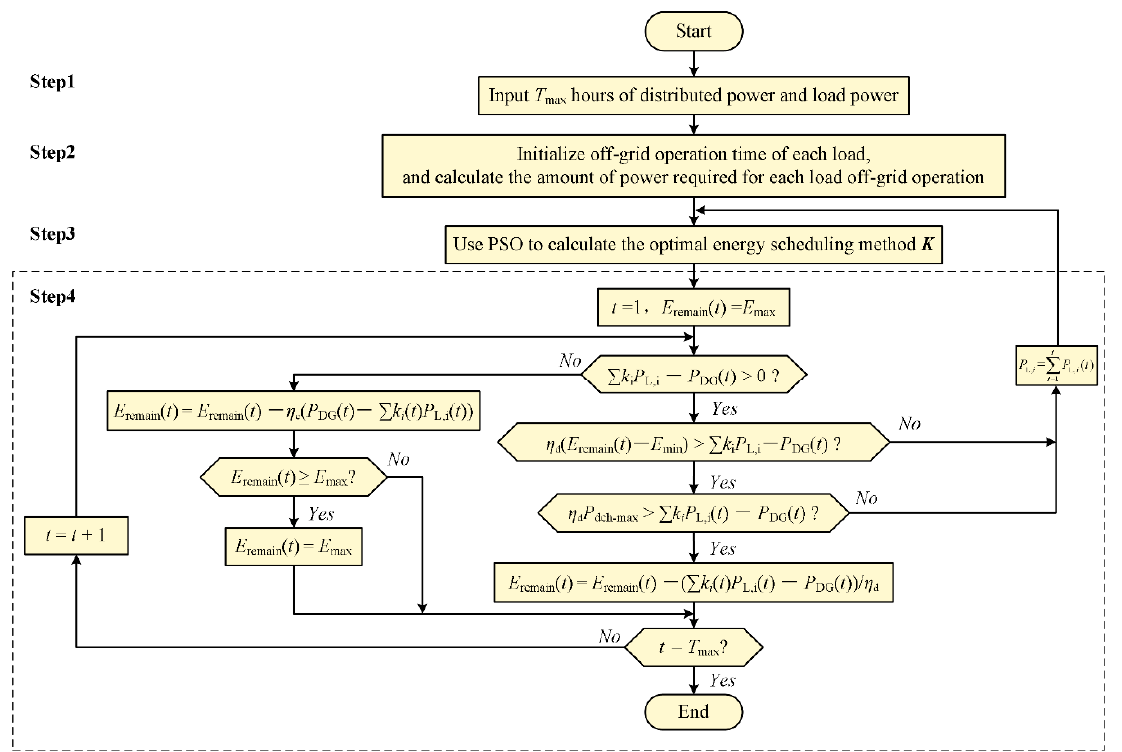
Figure 4. PSO algorithm used to solve the energy scheduling problem.